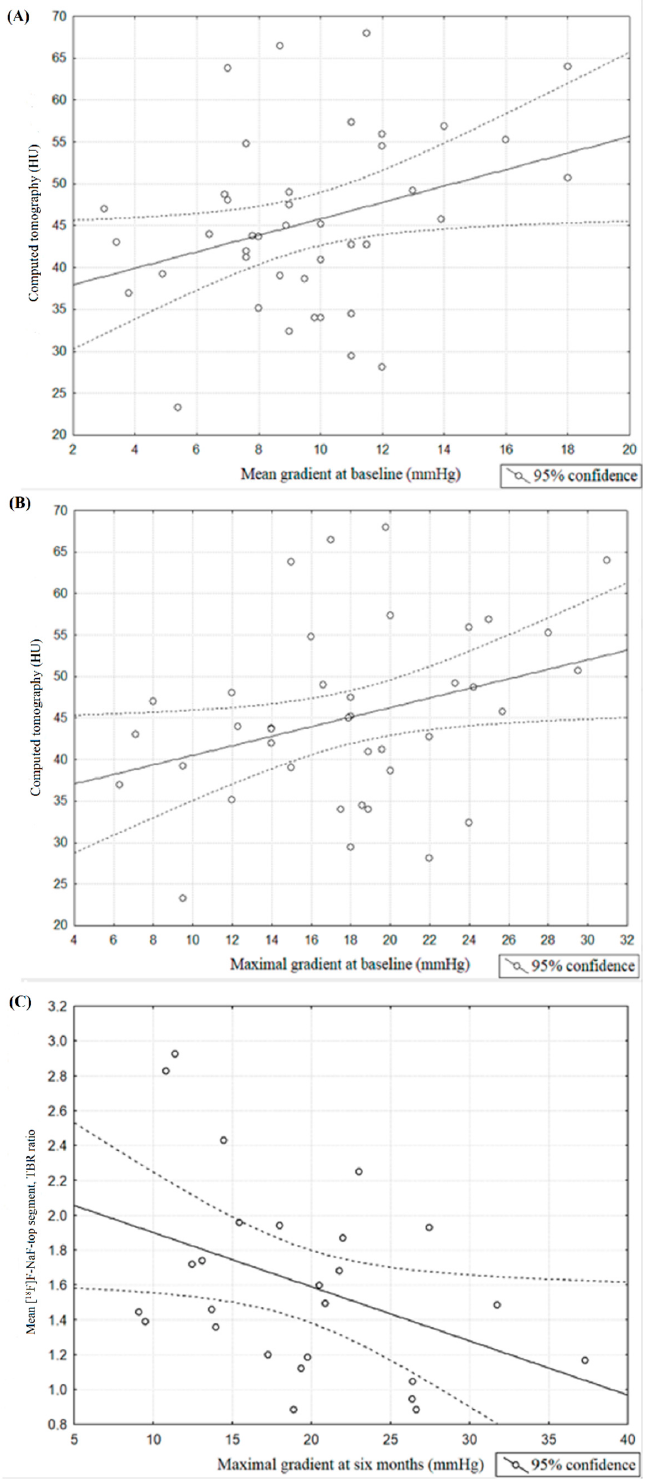
Figure 5. ( A ) Spearman’s correlation coefficient between mean aortic valve gradient measured at baseline and [ 18 F]F-fluorodeoxyglucose (HU) measured at 6 months after TAVI procedure. ( B ) Spearman’s correlation coefficient between maximal aortic valve gradient measured at baseline and [ 18 F]F-fluorodeoxyglucose (HU) measured at 6 months after TAVI procedure ( C ) Spearman’s correlation coefficient between maximal aortic valve gradient measured at 6 months and mean [ 18 F]F-sodium fluoride uptake of top segment corrected by mediastinal blood pool structures uptake assessed at 6 months after TAVI